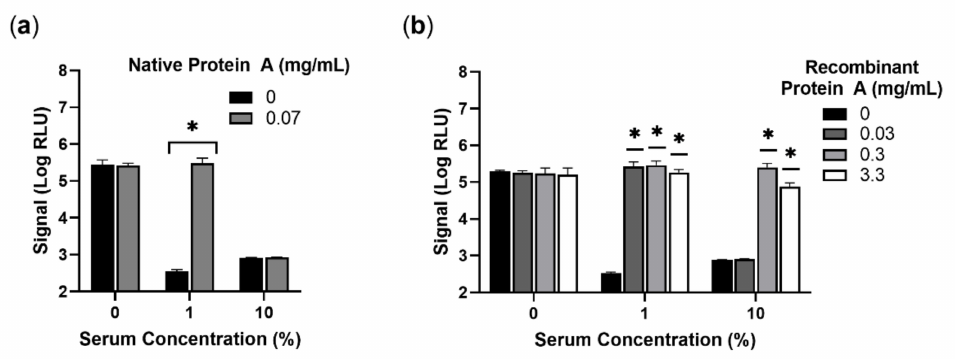
Figure 4. Use of protein A supplementation to recover phage-based signal in human serum. Native protein A from S. aureus ( a ), and recombinant protein A produced in E. coli ( b ) were diluted in TSB spiked with approximately 100 CFU of S. aureus (ATCC 12600). Assay wells also contained either 0, 1, or 10% off-the-clot human serum. Luciferase production was evaluated following a 4 h enrichment and a 2 h infection and is provided as log-transformed relative light units (Log RLU). Error bars represent standard deviation from triplicate wells. A two-way ANOVA with a Bonferroni’s multiple comparisons test was performed, comparing each condition with protein A back to the baseline signal without protein A (0 mg/mL). Asterisks (*) indicate significance ( p <